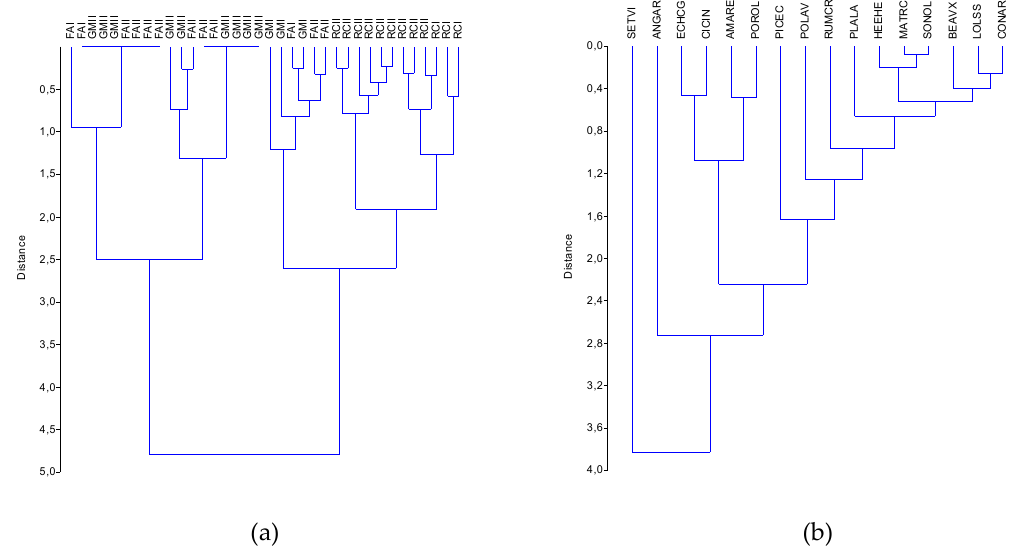
Figure 3. Hierarchical clustering run on ( a ) different treatment types (tillage systems) and ( b ) weed species. FA, fallow; GM, green manure; RC, in-line/roller crimper.